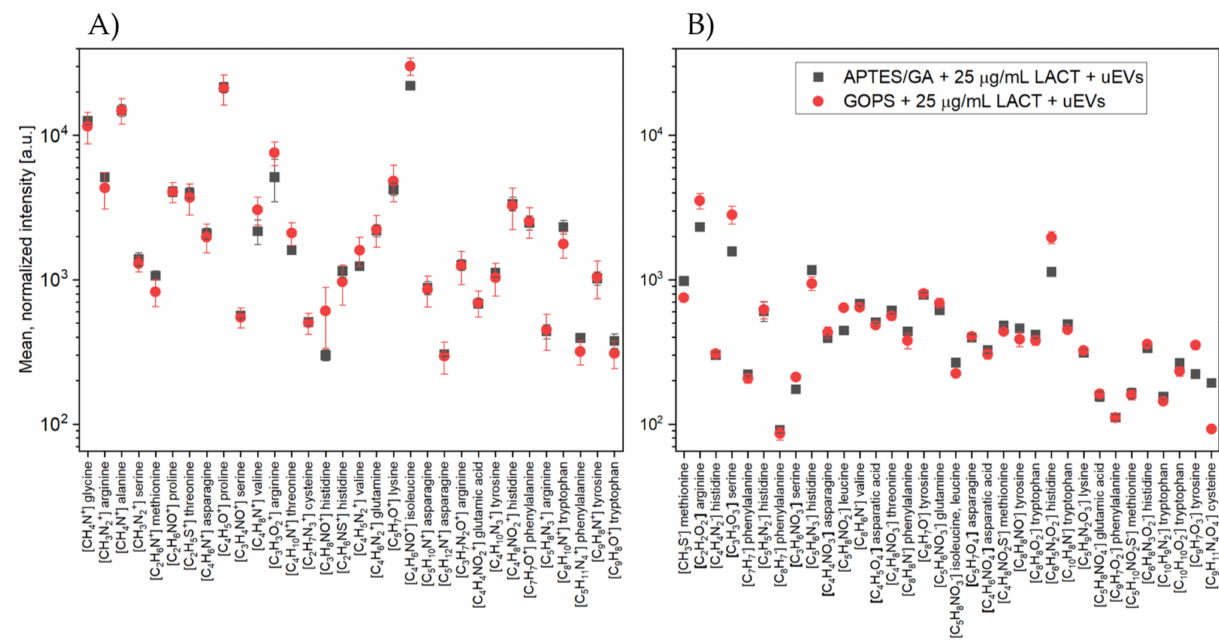
Figure 8. Values of mean normalized intensities for characteristic peaks of amino acids in ( A ) positive and ( B ) negative polarity, compared to the used silanes (APTES and GOPS), with uEVs applied to properly functionalized surfaces at a concentration of 3 × 10 9 particles/mL. These data refer to the LACT protein concentration of 25 µ